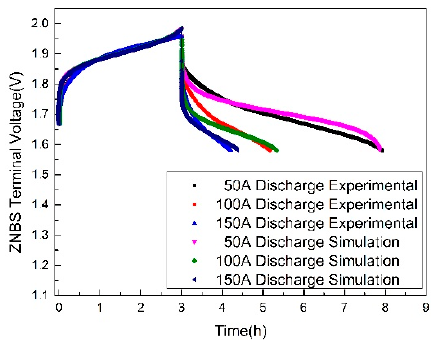
Figure 11. Coulombic efficiency estimation of 300 Ah zinc–nickel single-flow battery stack when charging at 100 A and discharging at three different currents (50 A, 100 A, 150